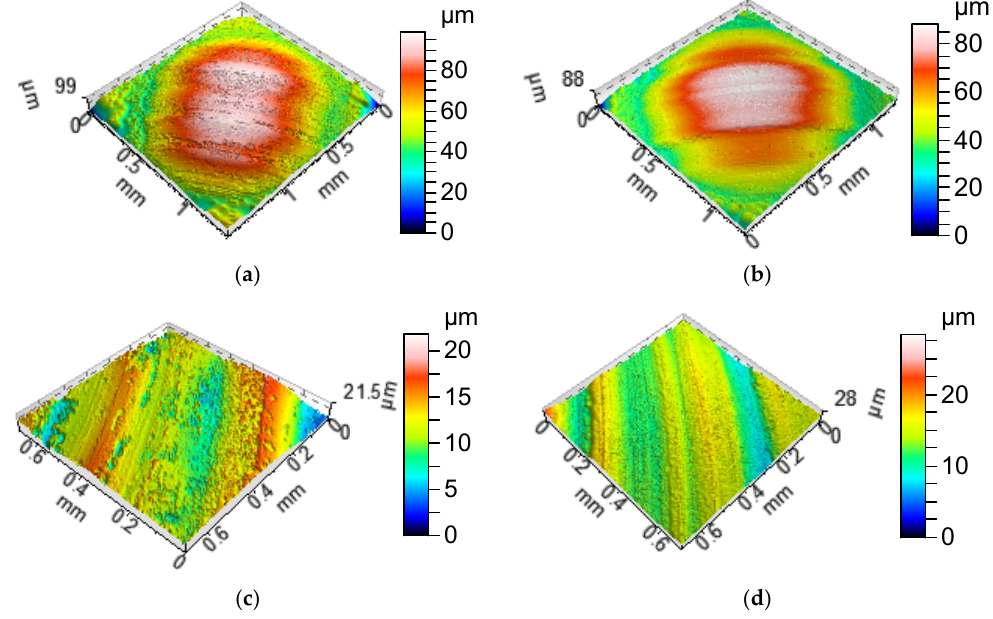
Figure 7. Isometric views of worn balls co-acting with the discs S4 ( a ) and S6 ( b ) and details of their worn surfaces co-acting with the discs S4 ( c ), S6 ( d ).